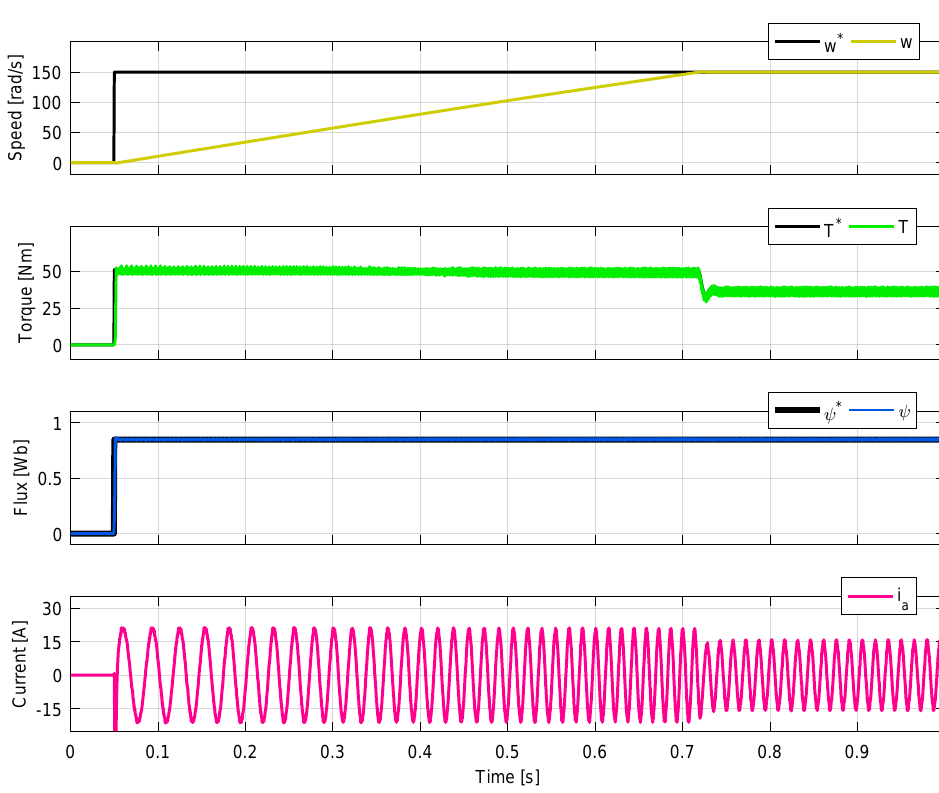
Figure 8. Results for 3L-NPC with N =